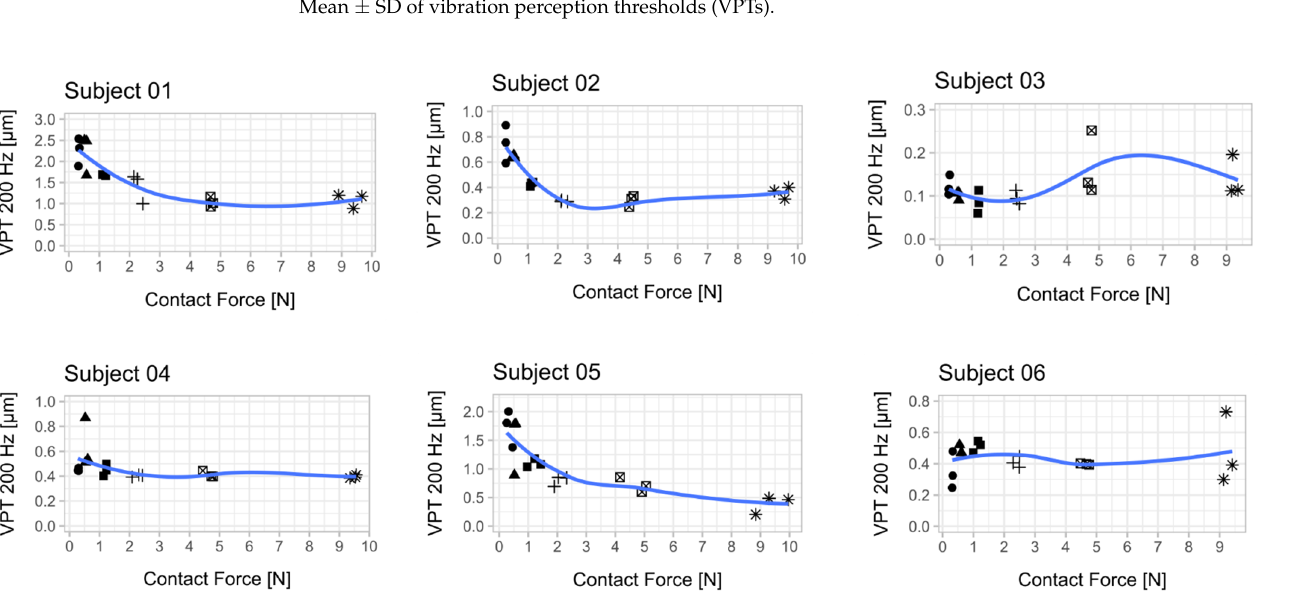
Table 1. Vibration perception thresholds [ µ m] for each contact force (N) and frequency (Hz). n = 10